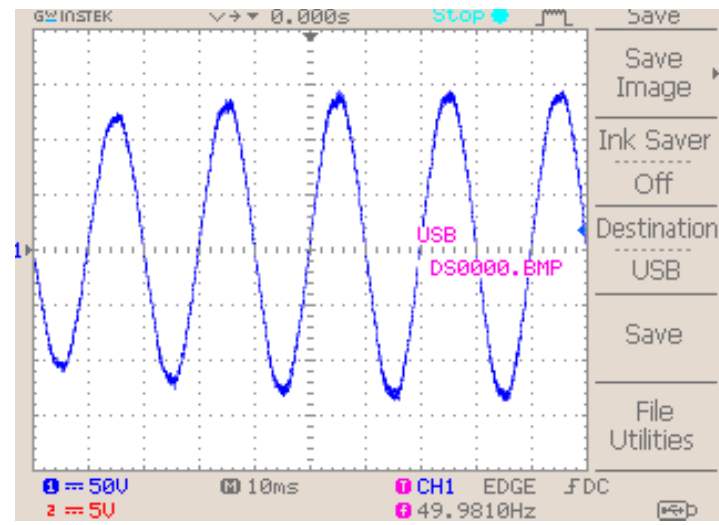
Figure 15. Input voltage waveform.